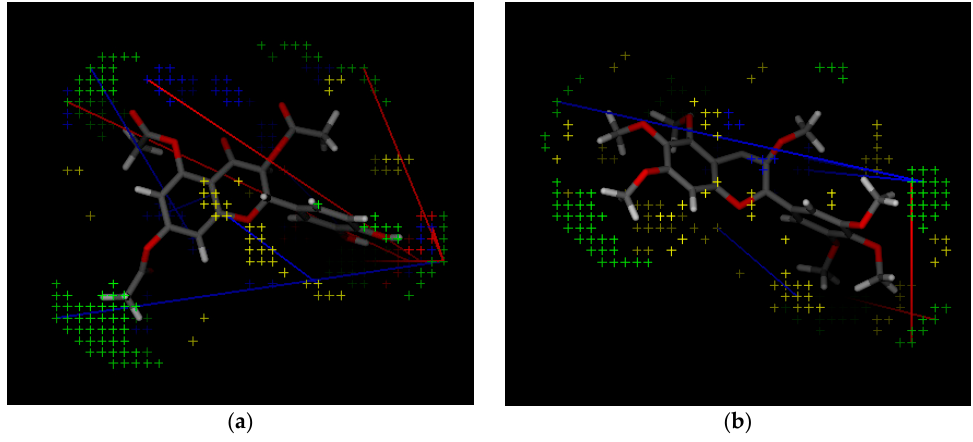
Figure 4. ( a ) The most active compound (CHEMBL3109443); and ( b ) the least active compound (CHEMBL3109440) in the Leishmania arginase model with PLS variables. Green dots: TIP probes, yellow dots: DRY probes, blue dots: N1, red dots: O probes. Lines that connect dots are variables, such as DRY—DRY, TIP—TIP, N1—TIP etc.